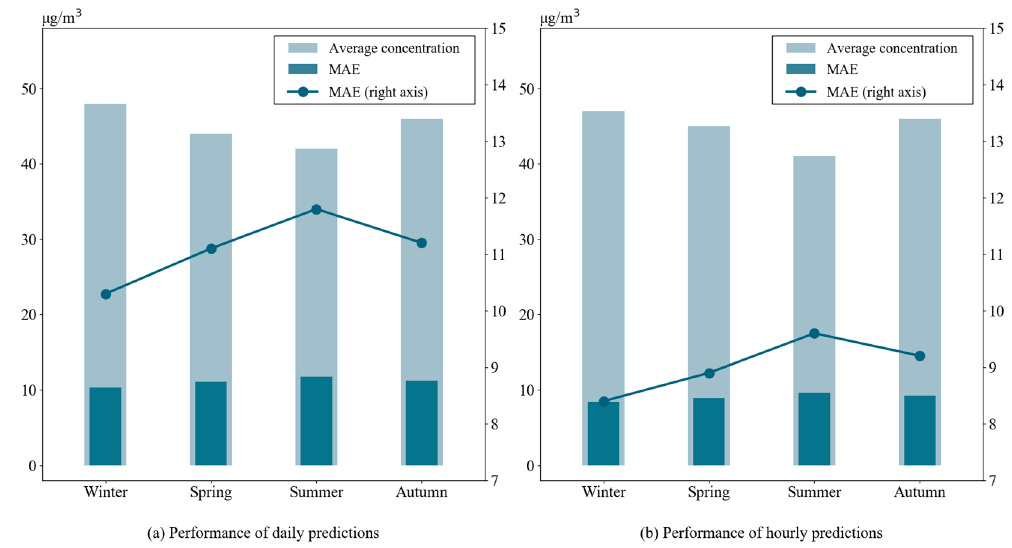
ff erent 2.5 in di